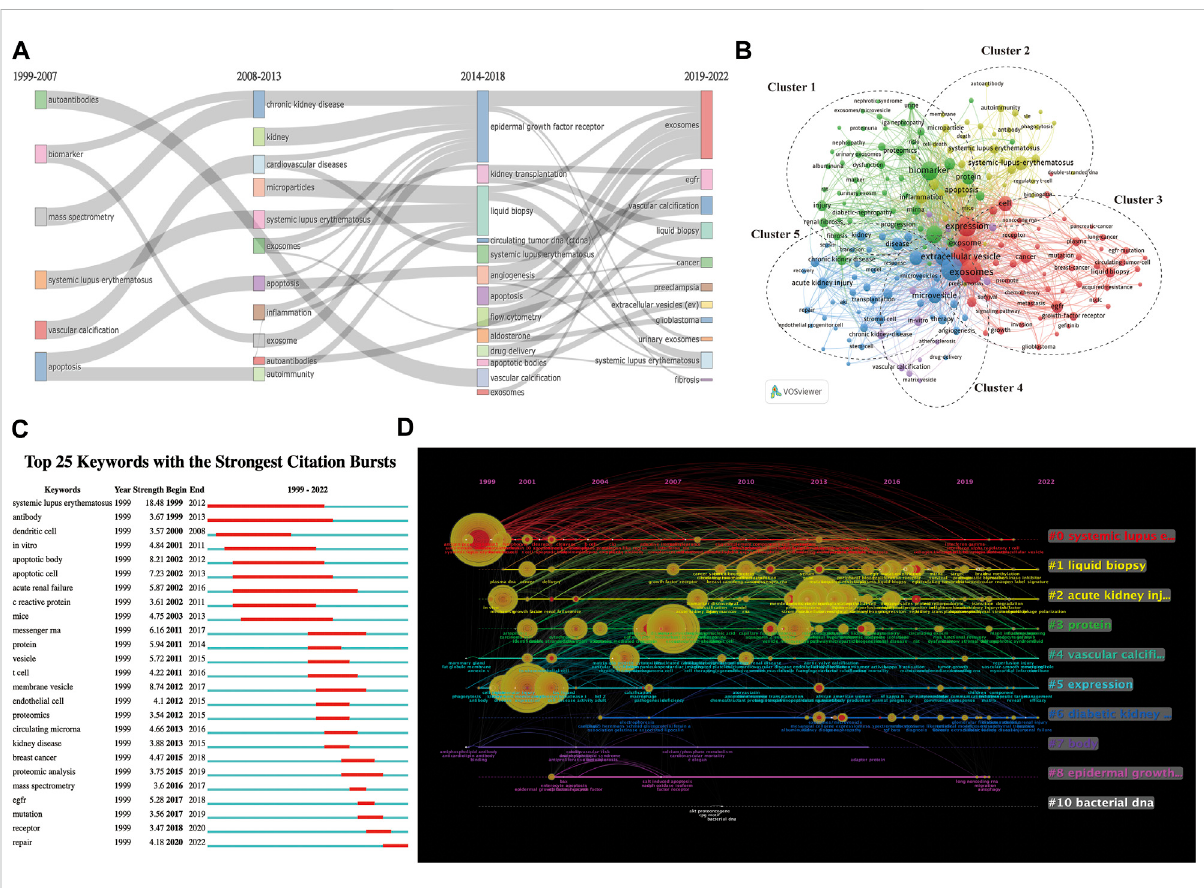
FIGURE 5 Keyword-related mapping in studies on EVs in kidney disease. (A) Major keywords evolution based on R for EVs in kidney disease research. (B) Visualizationbasedonkeywordco-occurrencerelationshipbasedonVOSviewerforEVsinkidneydisease.Inthisnetworkmap,keywordswithclose relationships are assigned to one cluster with the same color. All the keywords could be divided into fi ve clusters: cluster 1 (green nodes), cluster 2 (yellow nodes), cluster 3 (red nodes), cluster 4 (purple nodes), and cluster 5 (blue nodes). (C) Top 25 keywords with the strongest bursts